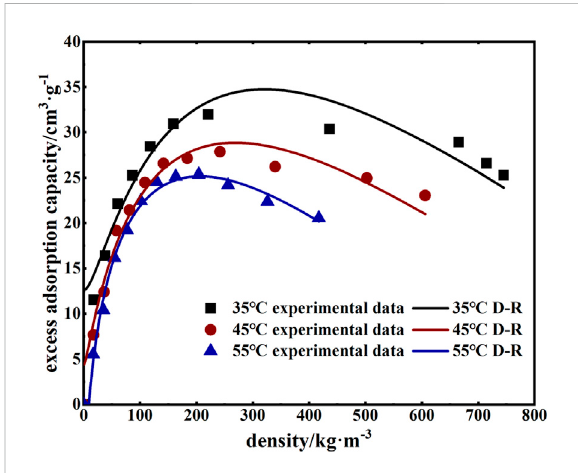
FIGURE 8 Change curves of CO 2 adsorption with pore